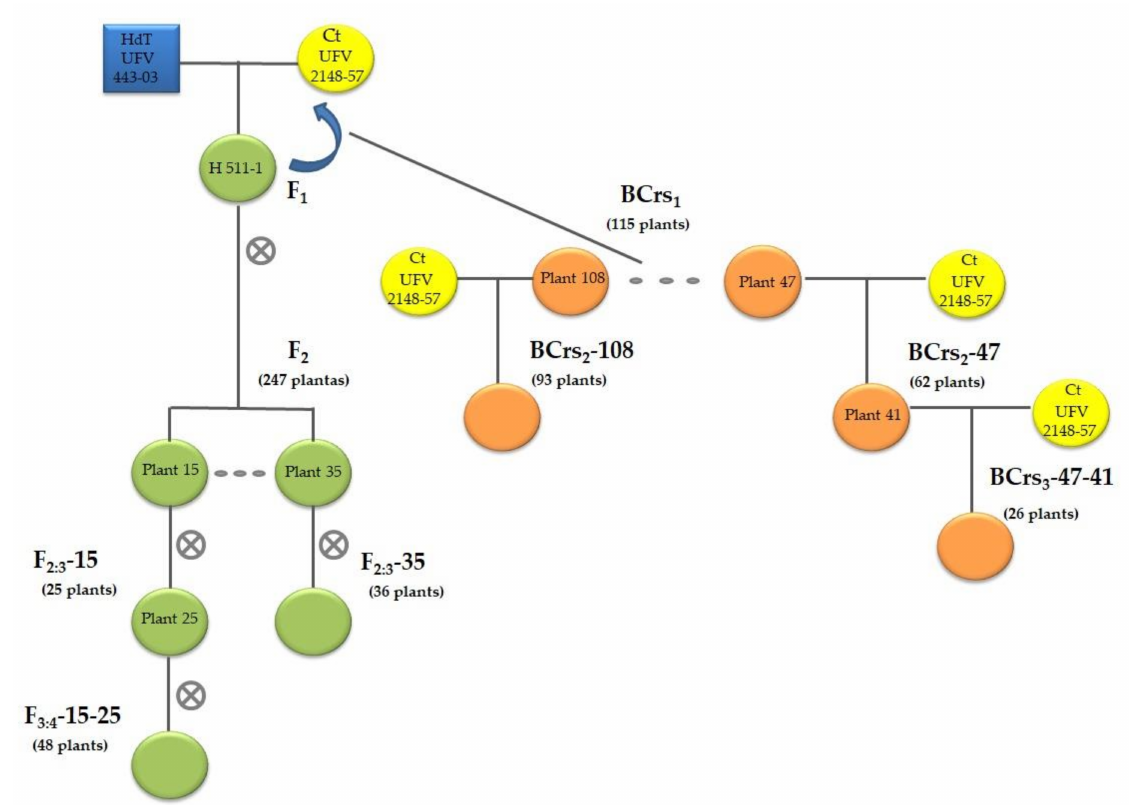
Figure 1. Crosses performed to test the developed markers and for marker-assisted selection of coffee with multiple disease resistance. ⊗ = controlled